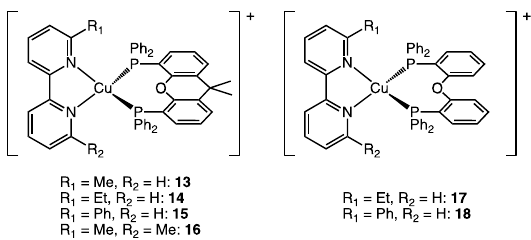
Figure 9. Structures of complexes 13 – 18 from reference [18]. Table 3. Reported PLQY values for powder samples for copper(I) complexes and %V bur for (NN), (PP), and (NN)(PP) units. Data are from reference [18].